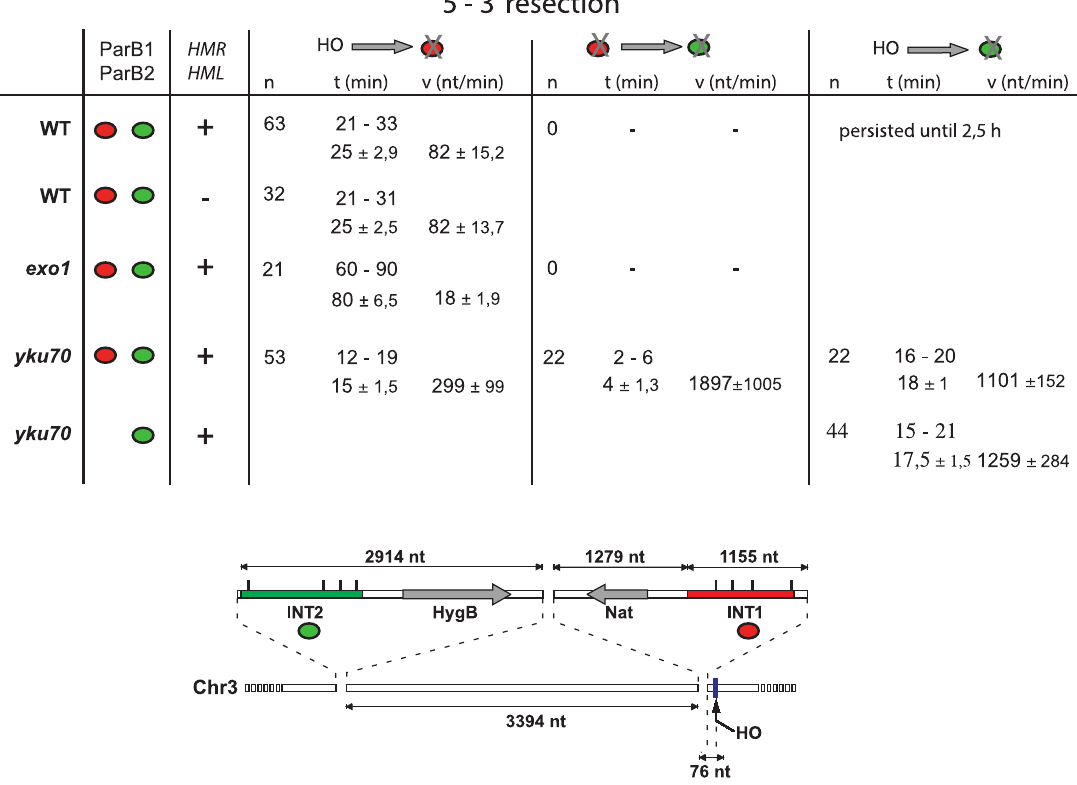
Figure 3. Resection timing and speed. MAT locus segments are resected from right to left. Data are shown as the range (top line) and average + / 2 standard deviation (bottom line). Calculation assumed resection to begin at the earliest time possible after HO induction (10 min), and resecting nuclease arrival at the distal end of the INT sections (1231 nt and 7612 nt from the HO cut-site for INT1 and INT2 respectively) to coincide with focus loss.